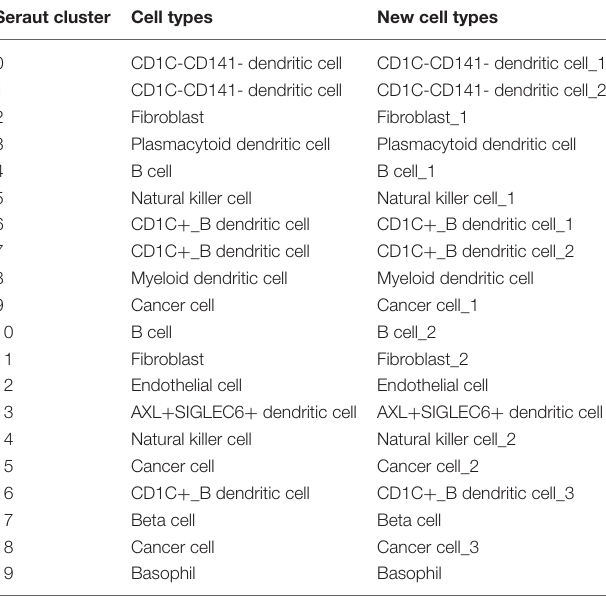
TABLE 2 | The information of 20 cell